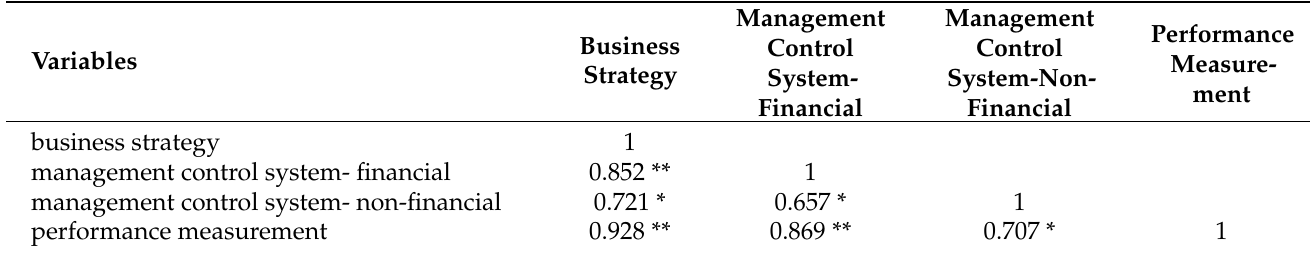
Table 12. Moderated regression ( R 2 ) analysis between variables participating in the test.